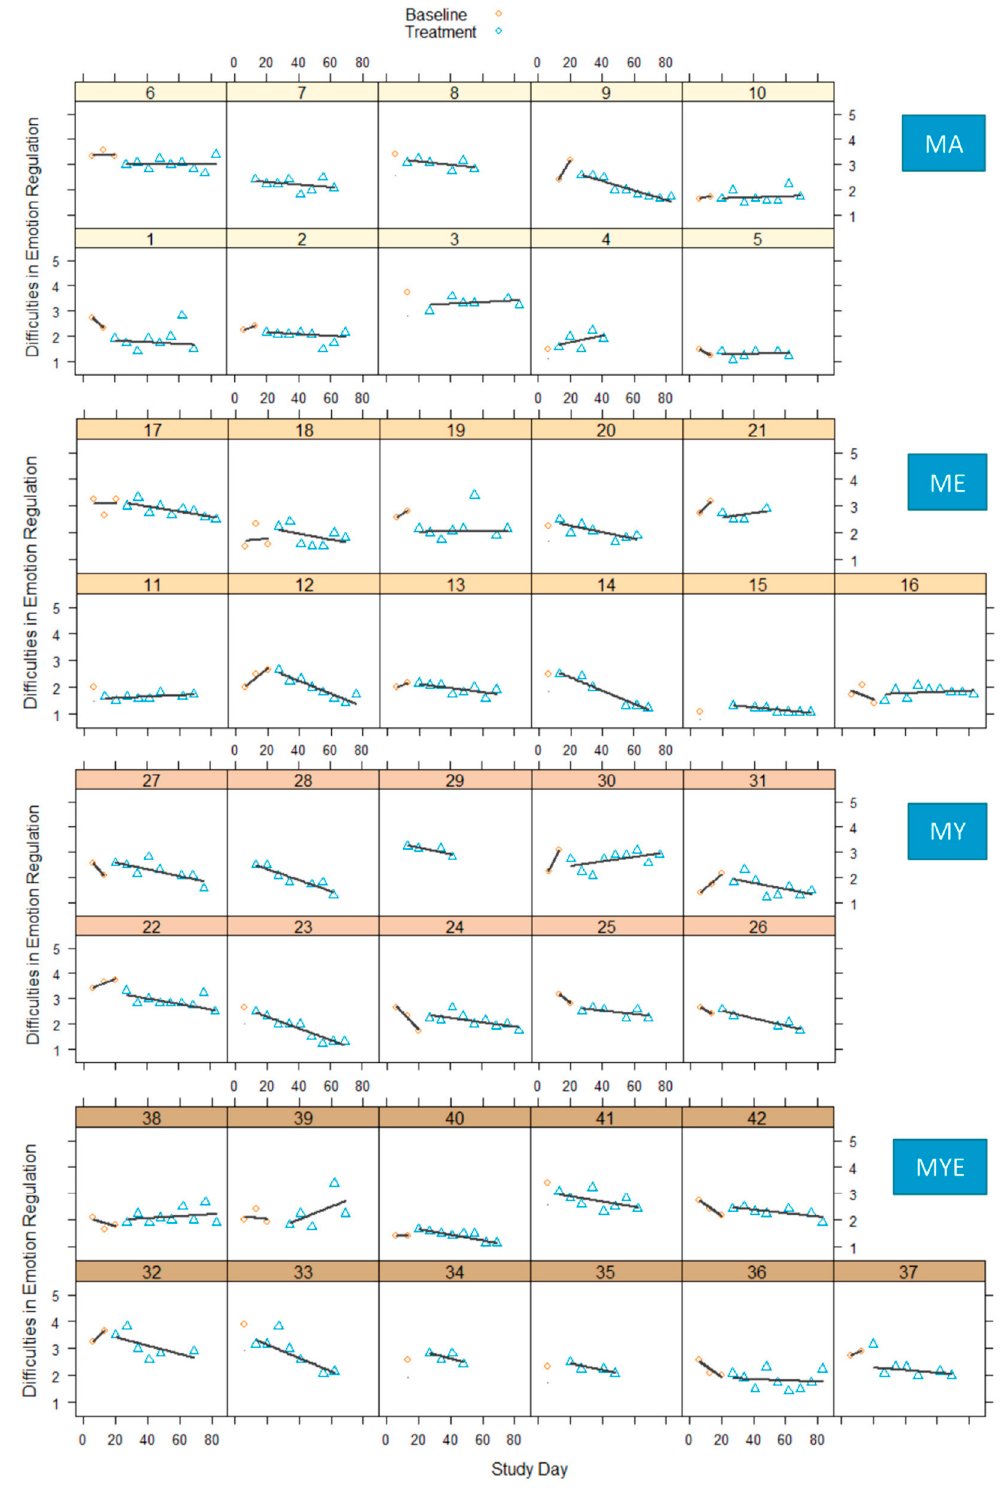
Figure 3. Difficulties in emotion regulation in four conditions during baseline and treatment phases for each participant with regression lines for each phase. Note . MA = Mantra meditation only; ME = meditation and ethical education; MY = meditation and physical yoga; MYE = meditation, physical yoga, and ethical